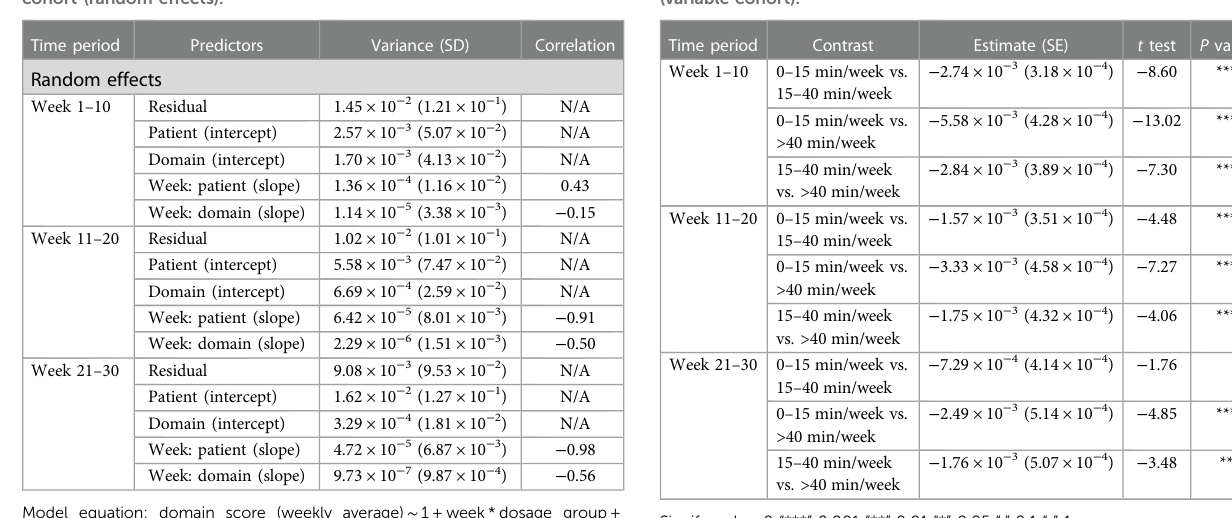
TABLE 7 Final linear mixed-effects model results summary of variable cohort (random effects).